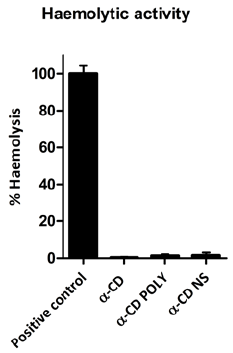
Figure 3. α -CD-based formulations presented negligible hemolytic activity. Results were expressed as percentage of total hemolysis (positive control), which was obtained when red blood cells were (SD) of the three experiments.